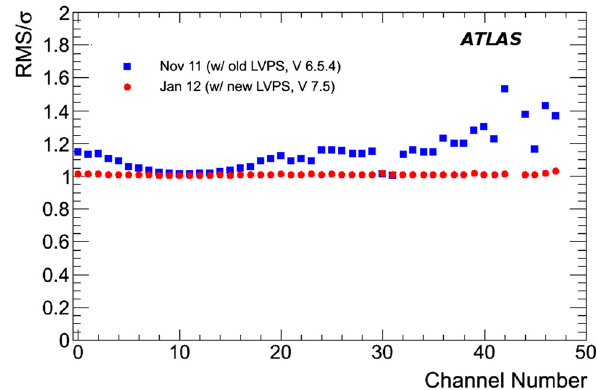
Fig. 8 The φ -averaged electronic noise (RMS) as a function of η of the cell, with both contributing read-out channels in high-gain mode. For each cell the average value over all modules is taken. The statisti- cal uncertainties are smaller than the marker size. Values are extracted using all the calibration runs used for the 2011 data reprocessing. The different cell types are shown separately for each layer: A, BC, D, and E (gap/crack). The transition between the long and extended barrels can be seen in the range 0 . 7 < | η | < 1 . 0